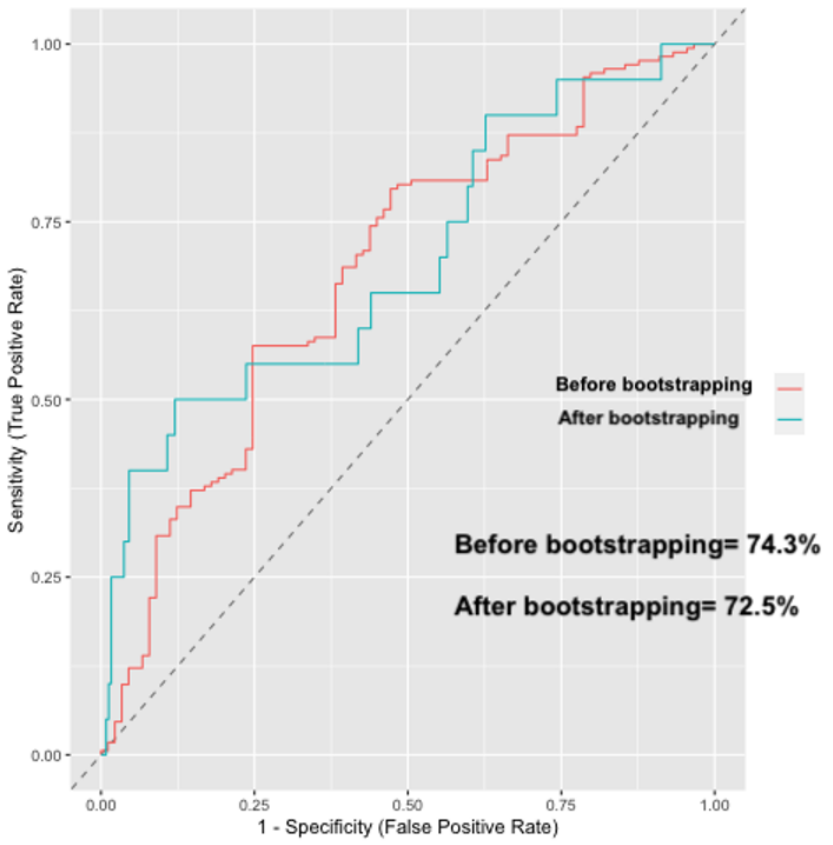
Figure 3. Receiver operating characteristic (ROC) curve and the corresponding area of the predictive model. Red line corresponded to the analysis before internal validation and green line corresponded to the analysis after bootstrapping-based internal validation.